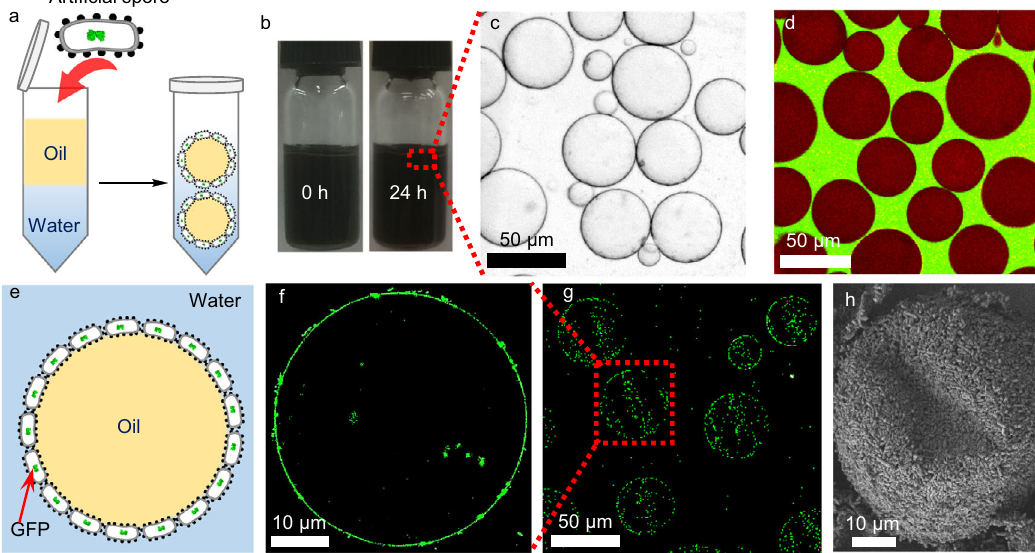
Fig. 5 Characterization of Pickering emulsion. a Scheme of emulsion preparation. b Emulsion appearance at 0 h and 24 h. c Optical microscopy image of the emulsions. d Confocal laser scanning microscopy (CLSM) image of the oil-in-water emulsions; red – organic phase, green – aqueous phase. e Scheme of emulsion droplet stabilized by arti fi cial spores with green fl uorescent protein (GFP). CLSM images of ( f ) an individual emulsion droplet and ( g ) an emulsion stabilized by arti fi cial spores containing GFP. h SEM image of an individual emulsion droplet surface.